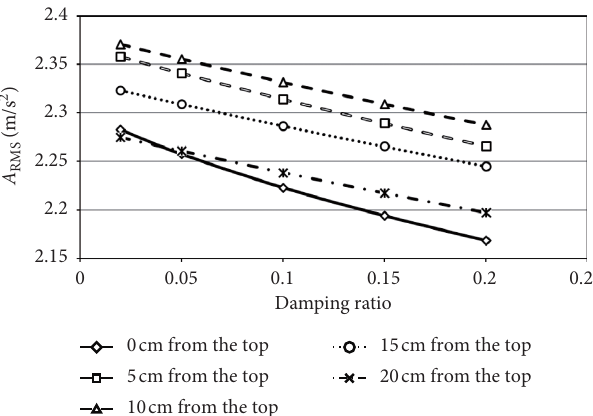
Figure 7: The effects of the damping ratio on vibration reduction (at monitored point A; damping layer thickness � 30mm).